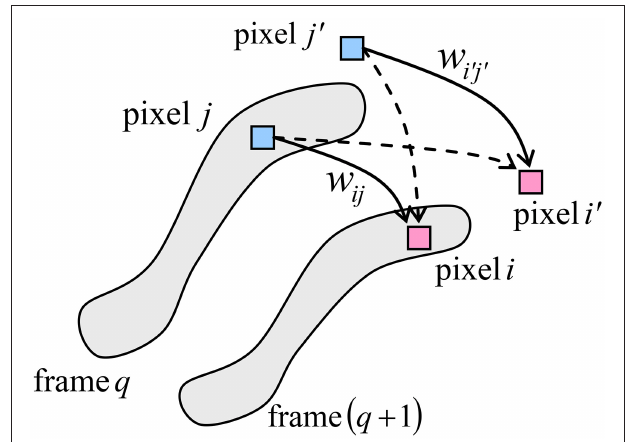
FIGURE 3 | The basic idea of operation of the neuromorphic ASTM. The shaded areas show the set of pixels “active” (say, black) in each of the two sequential frames.